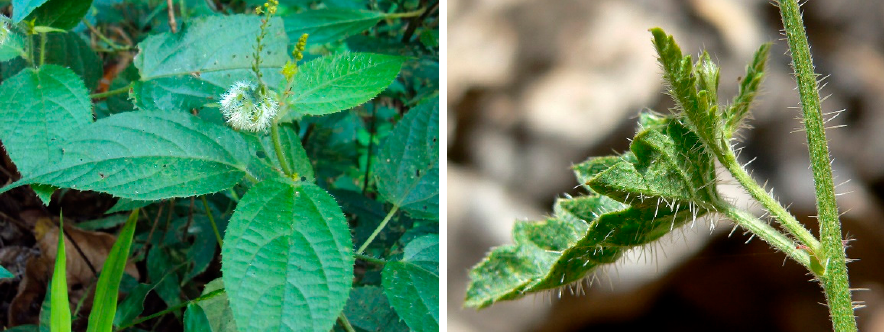
Figure 1. Tragia involucrata leaves, left. Tragia ramosa showing leaf and stem, covered by long, rough Scheme 3.0 license; right, Stan Shebs, GDFL license.